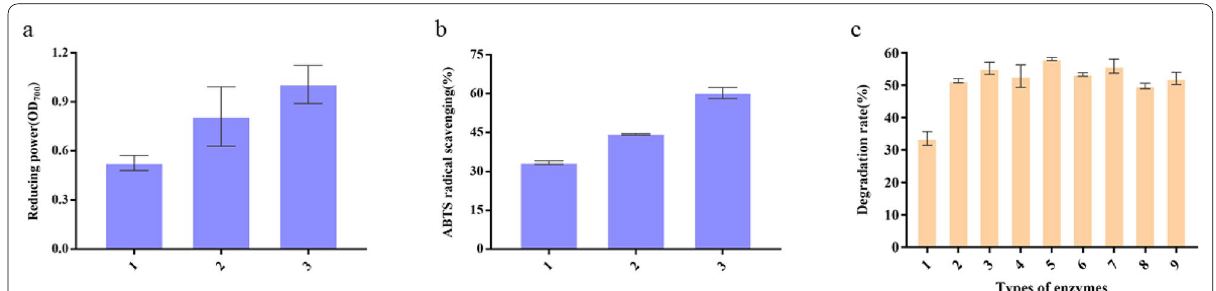
Fig. 5 Comparison of reducing power and degradation of feathers. a Reducing power (OD 700 ). 1, pMA5; 2, WT; 3, variant T18. b ATBS radical scavenging. 1, pMA5; 2, WT; 3, variant T18. c Degradation of feathers by combined enzymes. 1, WT; 2, variant T18; 3, papain and variant T18; 4, pepsin and variant T18; 5, trypsin and variant T18; 6, bromelain and variant T18; 7, flavor protease and variant T18; 8, neutral protease and variant T18; 9, alkaline protease and variant